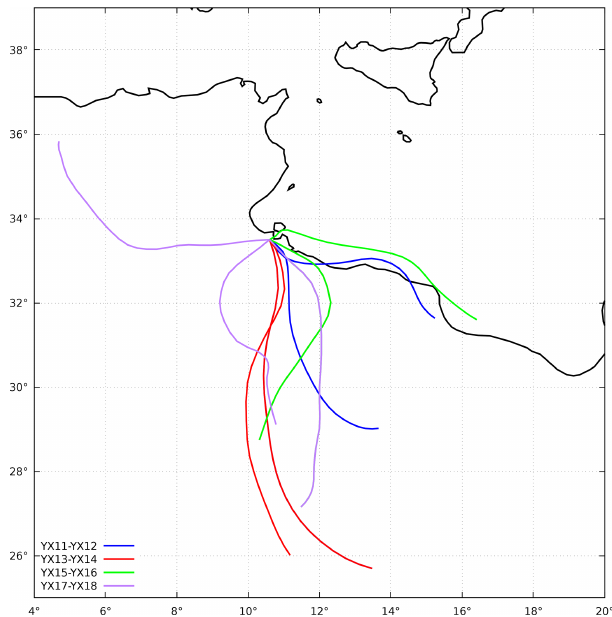
Figure C3. Backward trajectories of sample pairs YX11–YX12, YX13–YX14, YX15–YX16, and YX17–YX18. The x axis is lon- gitude, and the y axis is latitude. Two or three trajectories are asso- ciated with a given sample pair of ≈ 12h